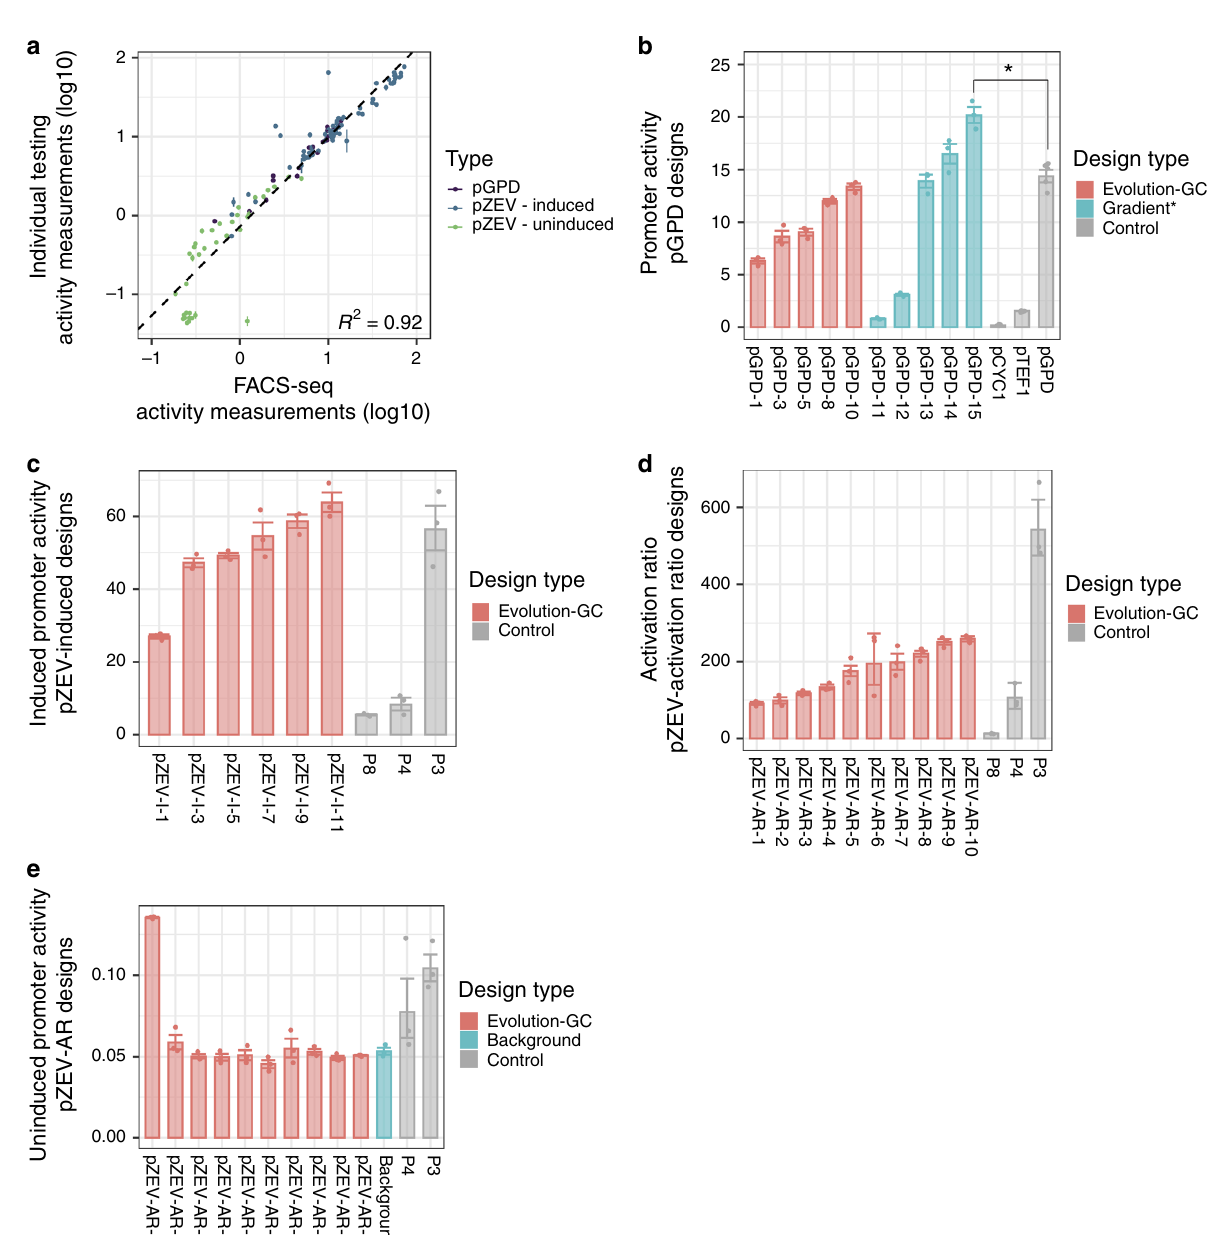
Fig. 4 Validating activities of individual designed promoters by fl ow cytometry characterization. a Promoter activity measurements (as base-10 logarithms) for selected sequences measured both in FACS-seq and by individual fl ow cytometry. FACS-seq: promoter activities determined from